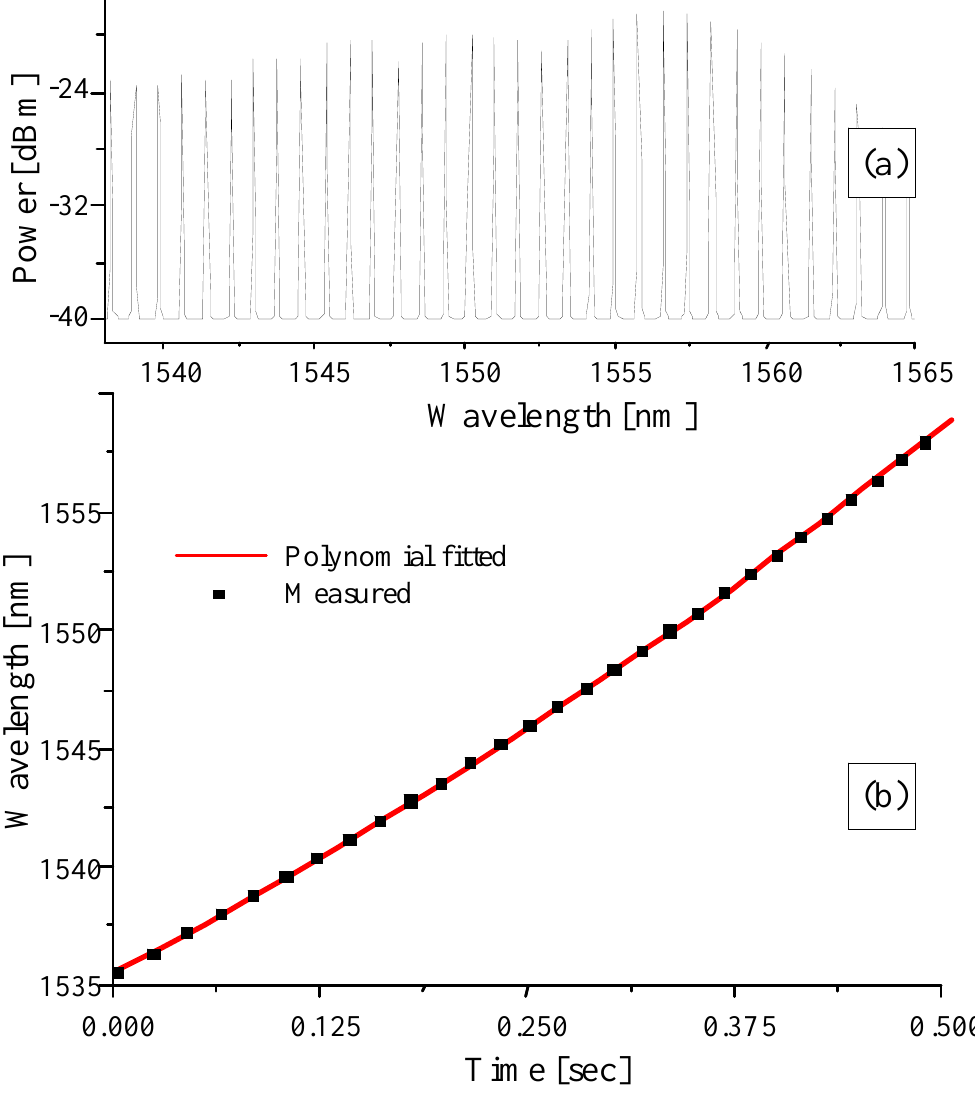
Figure3. Equidistant multi-wavelengths spectrum of